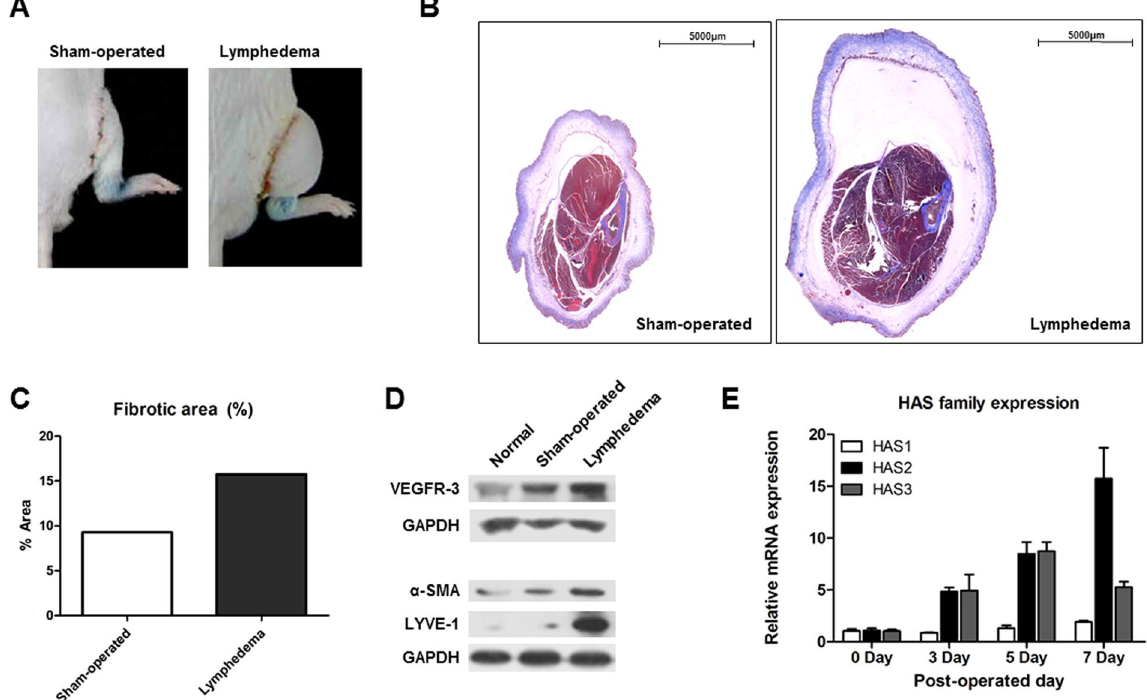
Figure 1. Analysis of the mouse model of lymphedema. Images of the right mouse leg at 3 days postsurgery. ( A ) Sham-operated mouse (without lymphatic damage) and mouse with lymphedema. ( B,C ) Cross-sectional mouse leg histology. Proximal slides were visualized via Masson’s trichrome staining. Scale bar = 5000 μ m. Collagen is denoted by blue staining. Percentages of fibrotic areas (blue areas) were determined using Image J software. ( D ) Western blot analysis of the lymphedema markers VEGFR-3 and LYVE-1, alpha-smooth muscle actin, and GAPDH as a loading control. ( E ) Quantitative real-time PCR analysis of the expression of various hyaluronic acid